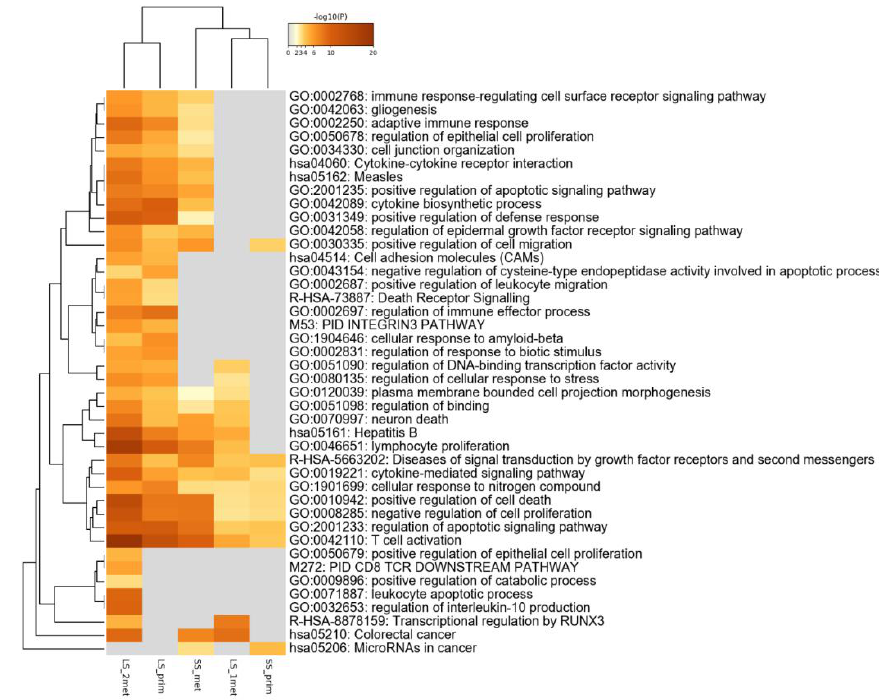
Figure 2. Global pathway enrichment of the detected alterations. LS_prim: primary tumor of the long survival case; LS_1met, LS_2met: metastatic samples of the long survival case; SS_prim: pri- mary tumor of the short survival case; SS_met: metastatic sample of the short survival patient. The PPI network, including proteins with relative genes which were found to be al- tered in the second metastatic samples, was built up. It can be observed that two sub- networks were identified, which were, in turn, functionally enriched (Figure 3A).